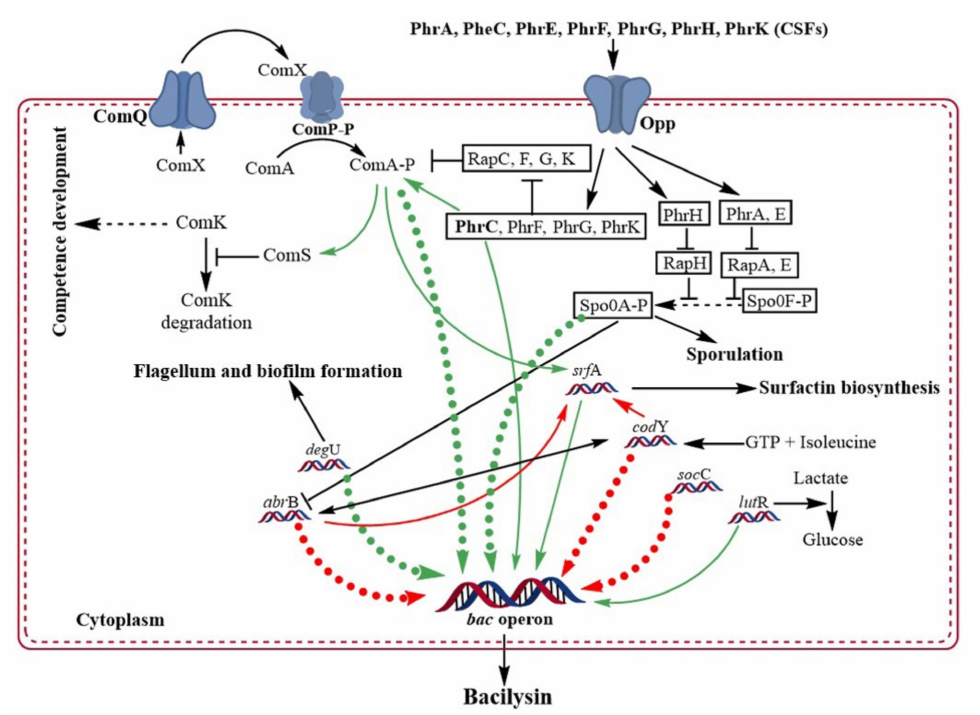
Figure 3. Transcription regulators that control bacilysin biosynthesis. Red bold dotted arrows indicate regulators that directly bind to the bac promoter and negatively regulate bacilysin biosynthesis, whereas green bold dotted arrows indicate regulators that regulate bacilysin biosynthesis positively by binding to the bac promoter. Other red and green arrows indicate regulators involved in indirect negative and positive regulation,